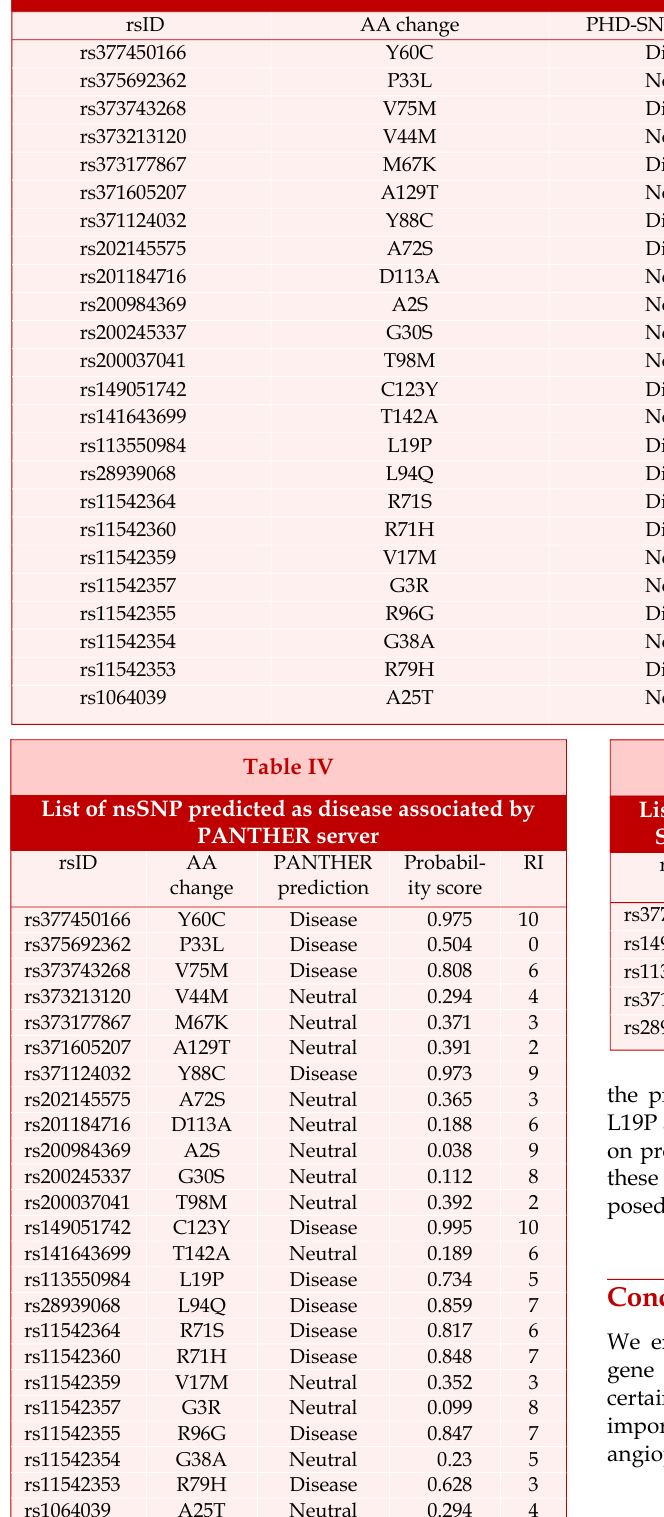
List of nsSNP predicted as disease associated by PHD-SNP server